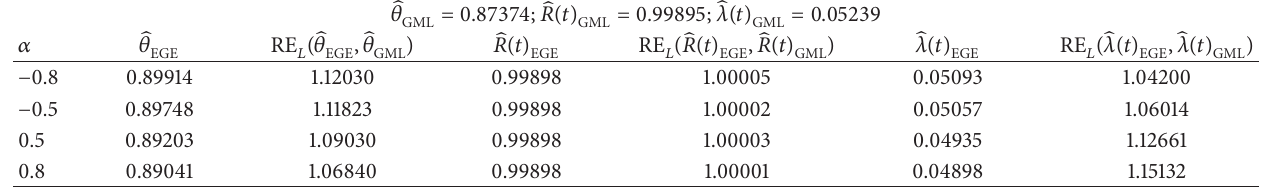
Table 9: The estimates and risk efficiencies for the conventional Type II censored